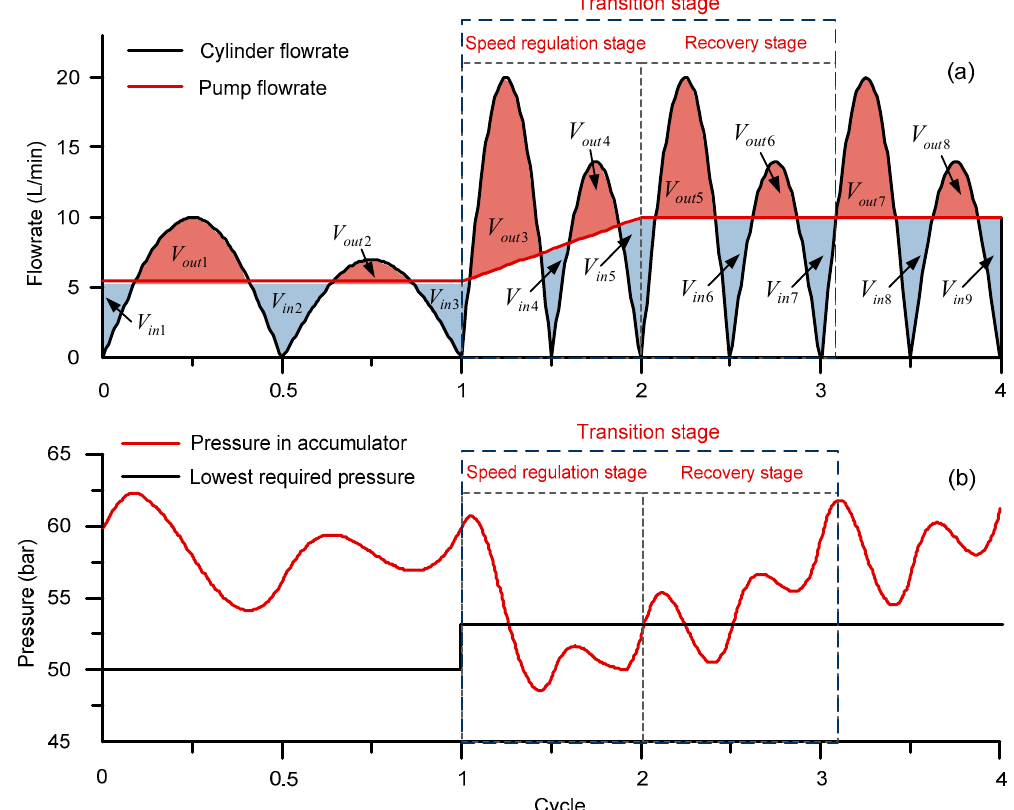
Figure 2. Performance of a traditional accumulator in a single cylinder hydraulic system when the working frequency is suddenly doubled: ( a ) flow rate of the pump and the cylinder; ( b ) oscillation of the accumulator pressure and the lowest required pressure.